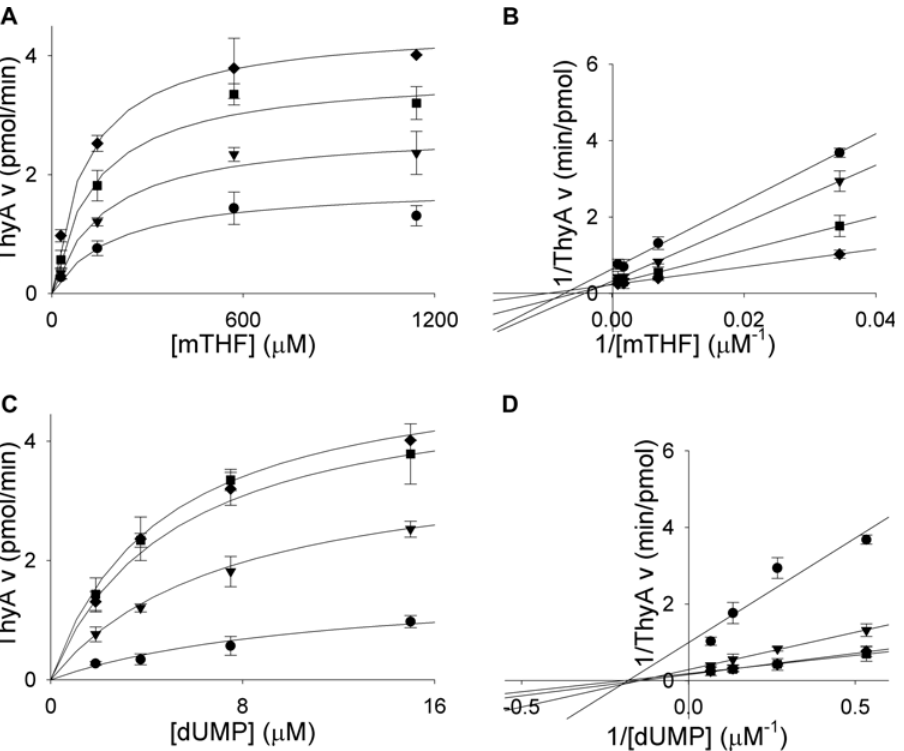
N , N , 29 m M; . , 143 m M; & , 571 m M; ¤ , 1143 m M). (D) Double